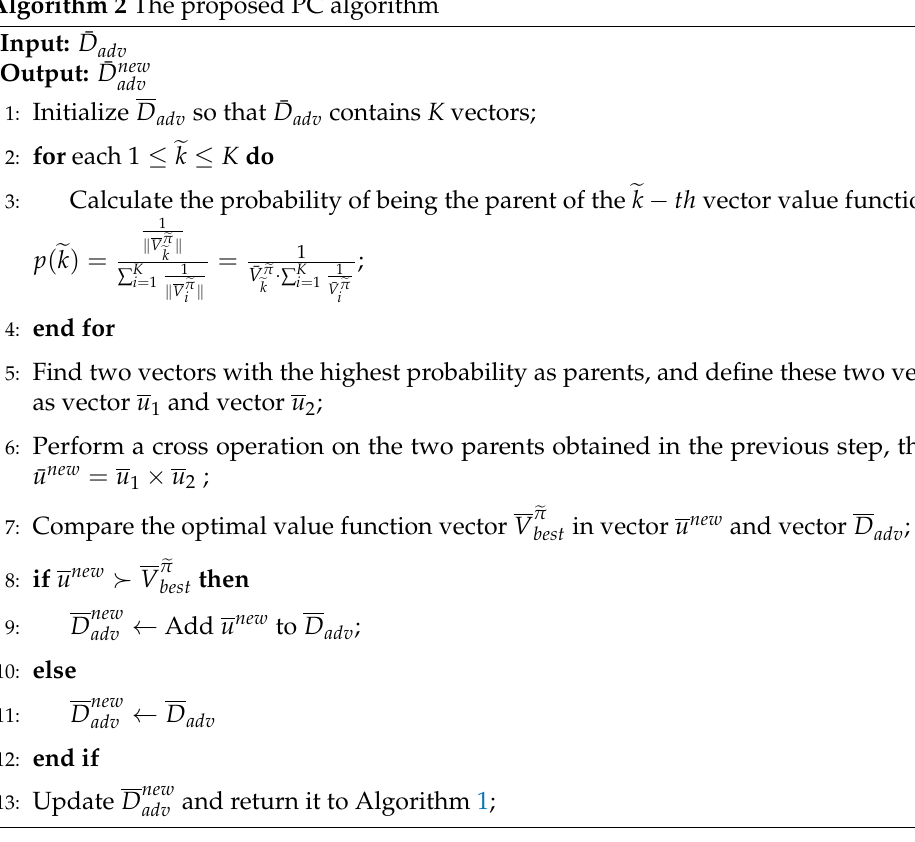
Algorithm 2 The proposed PC